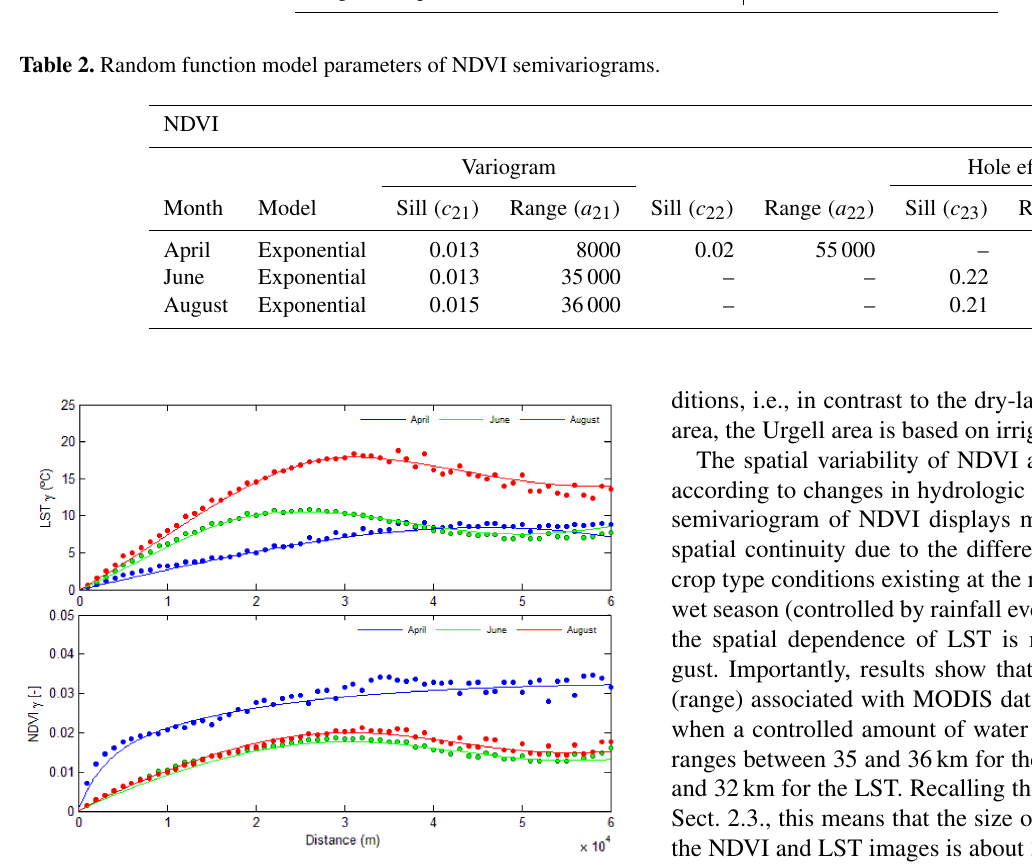
Figure 6. LST and NDVI experimental and theoretical semivari- ograms associated with April (blue), June (green) and August